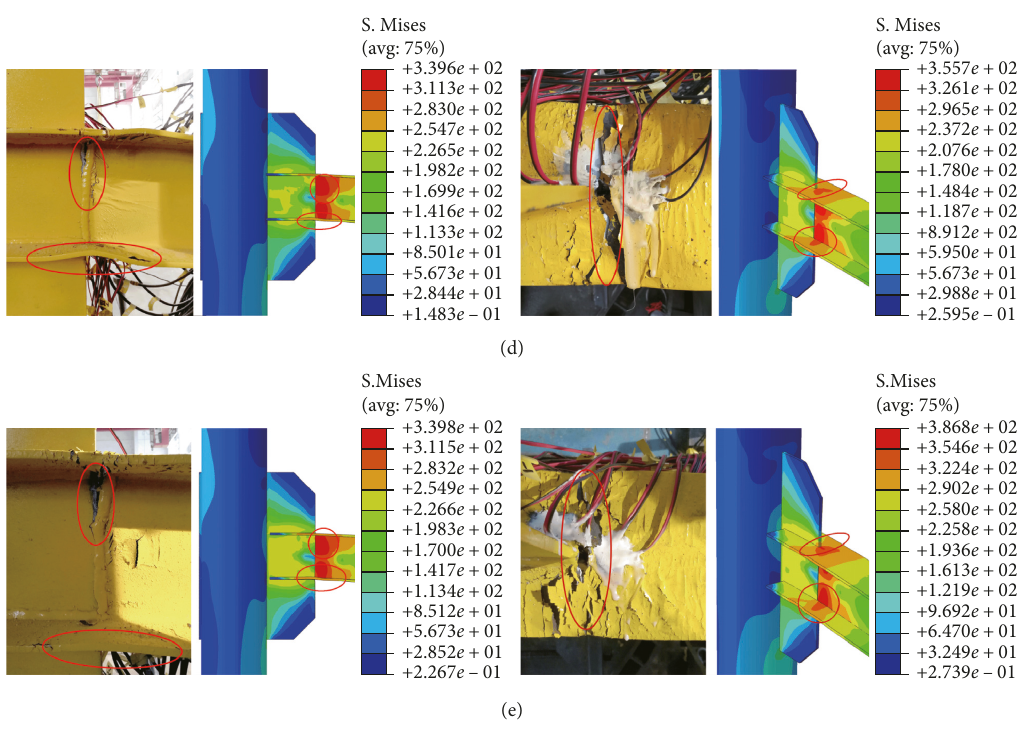
Figure 7: Loading procedure. (a) Failure mode of specimen SJ-1: experiment and FEM analysis. (b) Failure mode of specimen SJ-2: experiment and FEM analysis. (c) Failure mode of specimen SJ-3: experiment and FEM analysis. (d) Failure mode of specimen SJ-4: experiment and FEM analysis. (e) Failure mode of specimen SJ-5: experiment and FEM